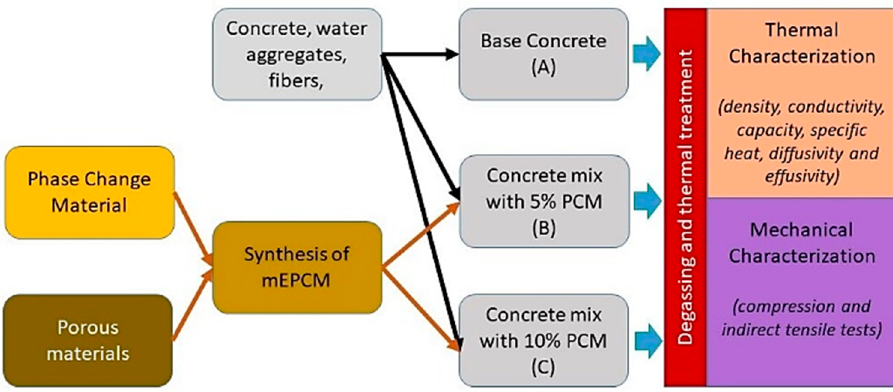
Figure 1. Flowchart of the methodology adopted to develop and characterize new concrete/mEPCM heat storage materials.